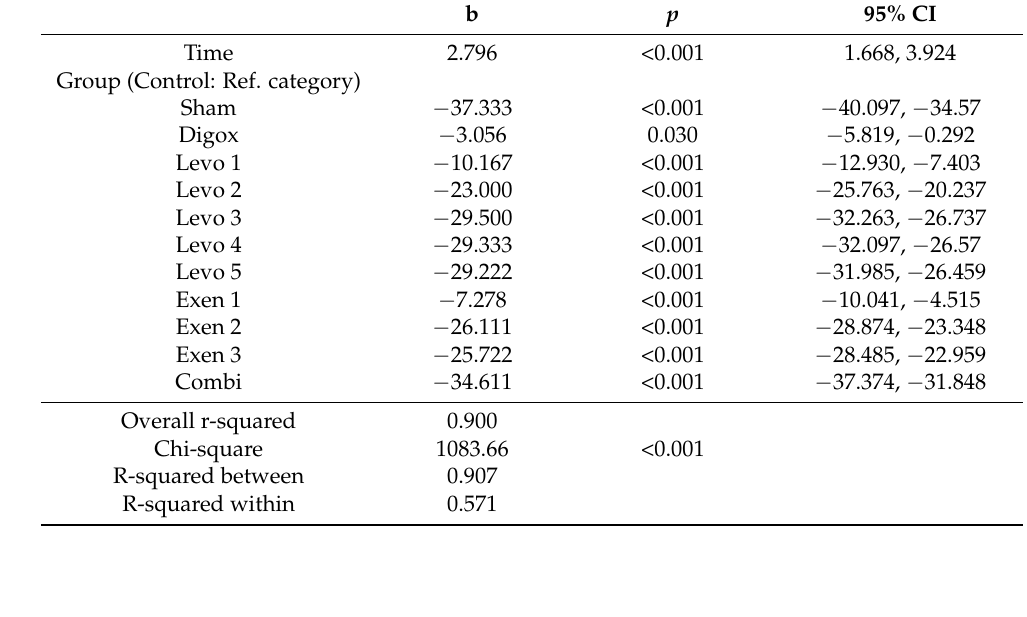
Table 13. Longitudinal analysis for LDH for all groups.